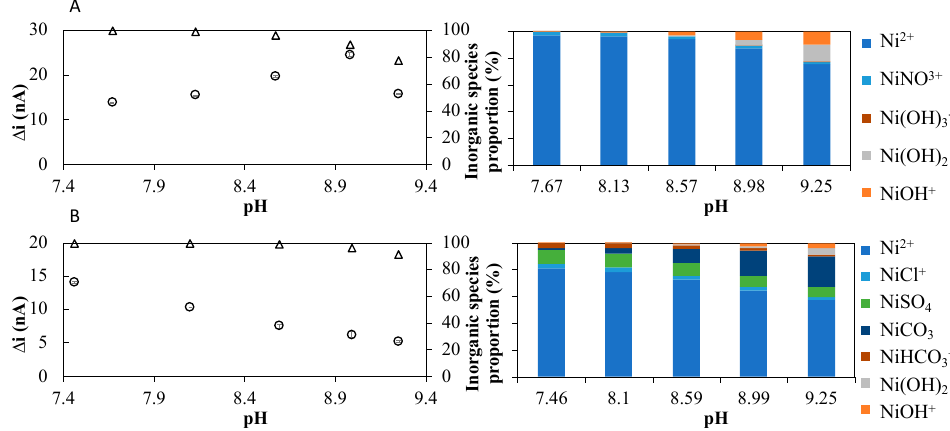
Figure 3. Left: Peak current intensity of the Ni recorded by Ad ‐ SWCSV (open circle) as well as the Visual MINTEQ simulated sum of dynamic inorganic Ni species percentage (open triangle) in the range of the studied pH in the synthetic media ( A ) and seawater ( B ). Right: Visual MINTEQ predicted inorganic Ni species and their percentage as a function of pH in the synthetic media ( A ) and seawater ( B ).